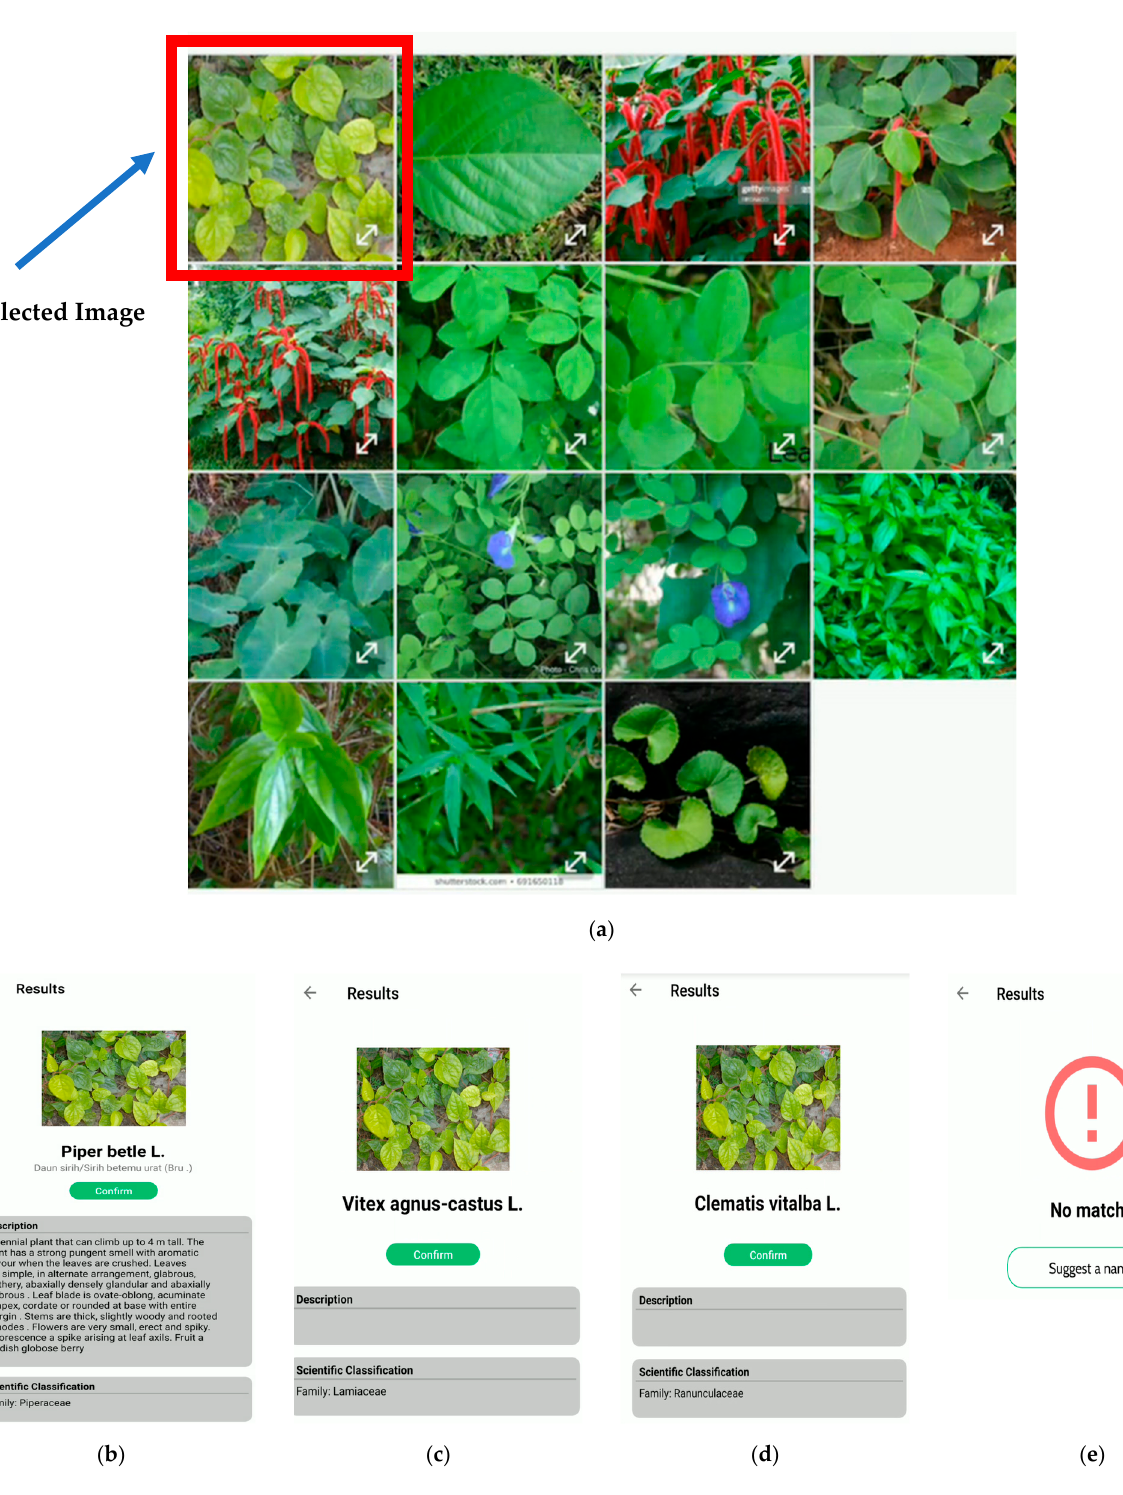
Figure 8. Examples of offline classification of a plant by using the mobile application and feedback option for correction/suggestion for the plant name. ( a ) Images from the gallery for offline testing: ( b ) first matching, ( c ) second matching, ( d ) third matching, and ( e ) feedback option.